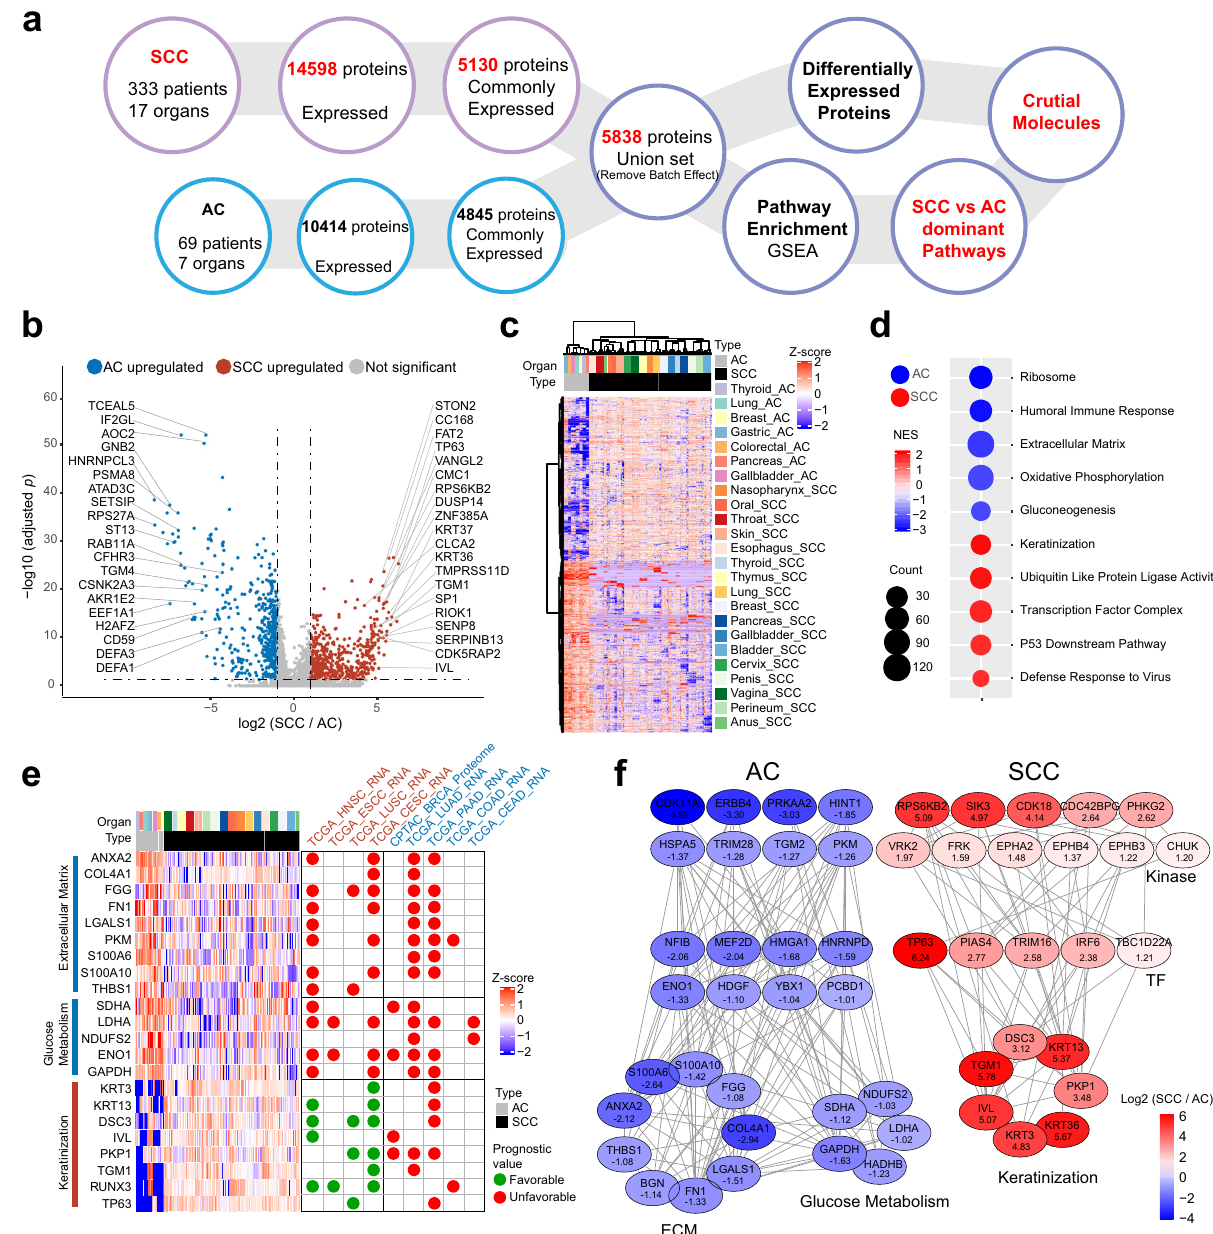
Fig. 2 Proteomic differences of pan-SCCs and pan-ACs. a The work fl ow for differential analysis between pan-SCCs and pan-ACs. A total of 5838 proteins commonly expressing in SCCs and/or ACs was obtained and differentially expressed proteins were calculated (Wilcoxon rank-sum test), and Gene set enrichment analysis (GSEA) was performed. b , c A volcano plot and a heatmap showed the results of a two-sided Wilcoxon rank-sum test (BH-adjusted p < 0.05, fold change > 2) comparing pan-ACs and pan-SCCs. Signi fi cantly differentially expressed proteins were labeled in the volcano plot. d GSEA revealed the pathways that were signi fi cantly enriched in pan-ACs and pan-SCCs. NES, normalized enrichment score. e The prognostic value of differentially expressed proteins in pan-AC-enriched pathways (extracellular matrix and glucose metabolism) and pan-SCC enriched pathway (keratinization) by exploring pan-SCC cohort (this study) and 9 TCGA datasets. P values of pan-SCC cohort were from multivariate Cox proportional hazard model (including age, gender, TNM stage, protein expression, organ, and histology), and p values for 9 TCGA datasets were from log-rank test. f The regulation network of kinases, TFs, and DEPs in pan-ACs and pan-SCCs. All kinases, TFs, and DEPs were colored by log2